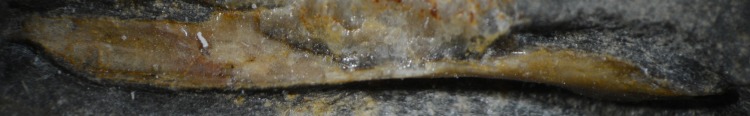
Right cleithrum of NMS G 1993.54.1, the holotype of Casineria kiddi, in caudal view, showing postbranchial lamina (compare fig. 70-2.4 of Pawley, 2006).Ventral end on the left. Total length about 11.5 mm. Photo taken by D. M.